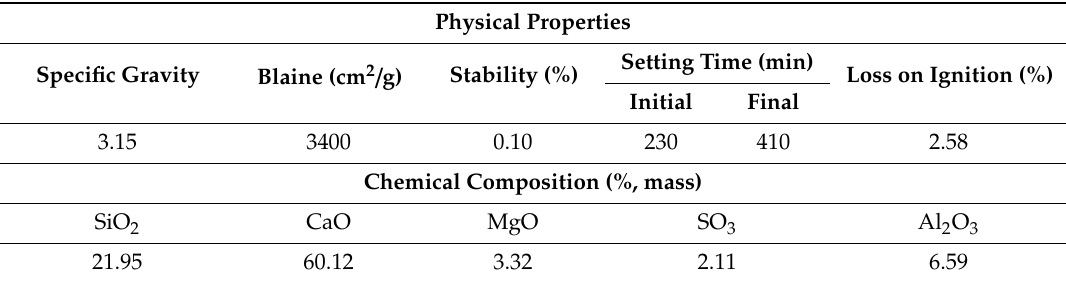
Table 1. Physical and chemical properties of the used